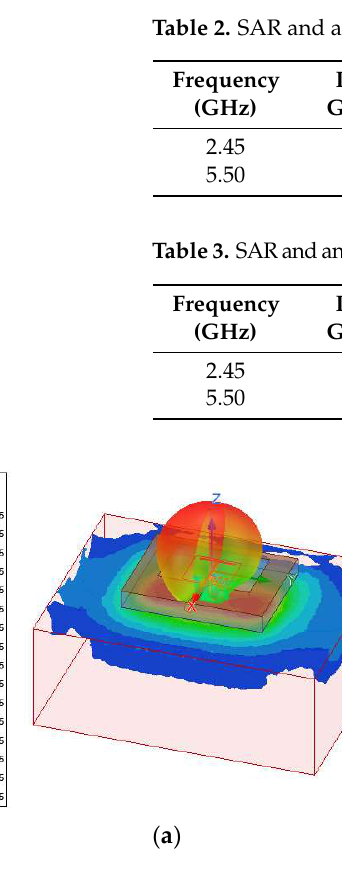
Figure 6. SAR values for the proposed antenna on a block of average tissue, using 1-g average SAR and input power for 50 mW: ( a ) 2.45 GHz; ( b ) 5.5 GHz.